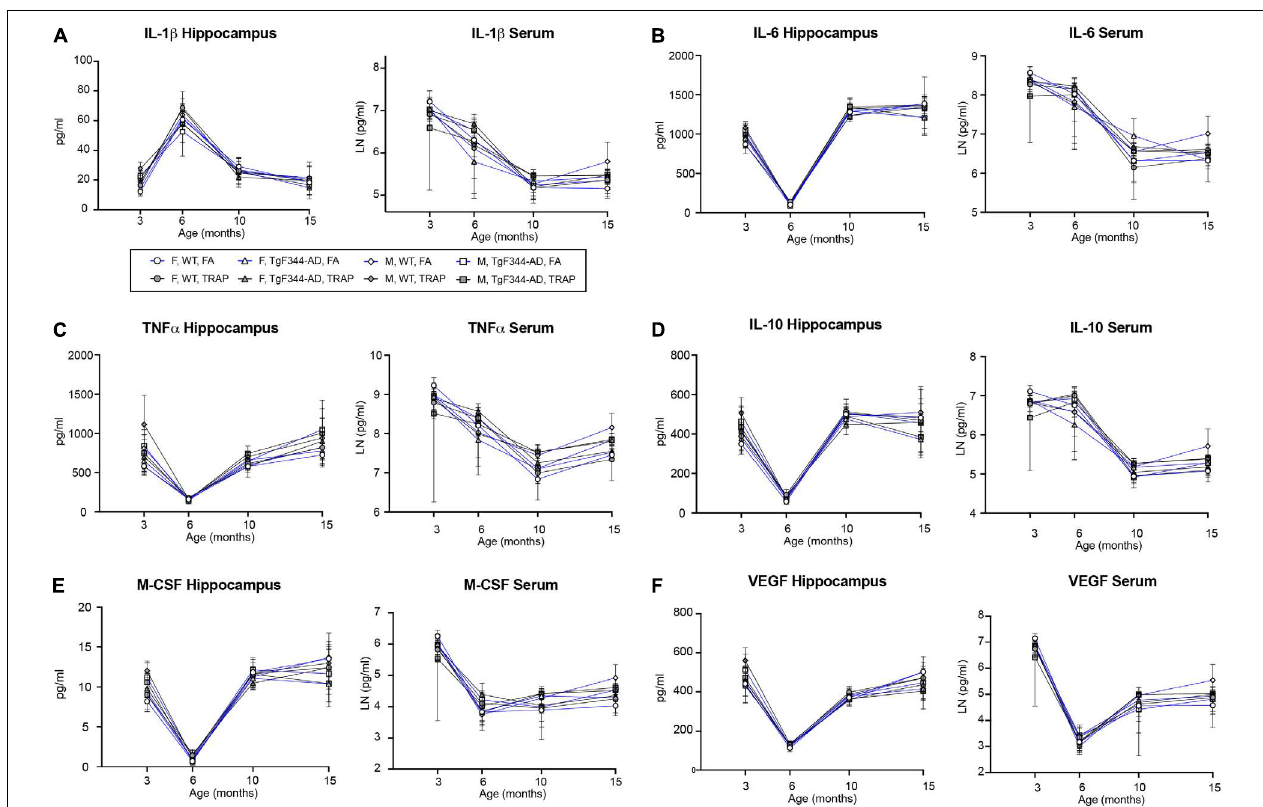
FIGURE 1 | Neither TRAP exposure nor expression of AD risk genes significantly alter age-related changes in cytokines and growth factors in the rat hippocampus and serum. Hippocampal and serum levels of representative cytokines and growth factors in TgF344-AD and WT rats exposed to FA or TRAP beginning at postnatal day 28 and continuing for up to 15 months of age. Representative analytes include (A) IL-1 β , representative of the inflammasome; (B) IL-6 and (C) TNF A , representative of Th1/pro-inflammatory cytokines; (D) IL-10, representative of Th2/anti-inflammatory cytokines; and (E) M-CSF and (F) VEGF, representative of growth factors. Data points represent the mean ± S.D. ( n = 4–5 animals per group). Samples were assayed in duplicates; F, females; M,